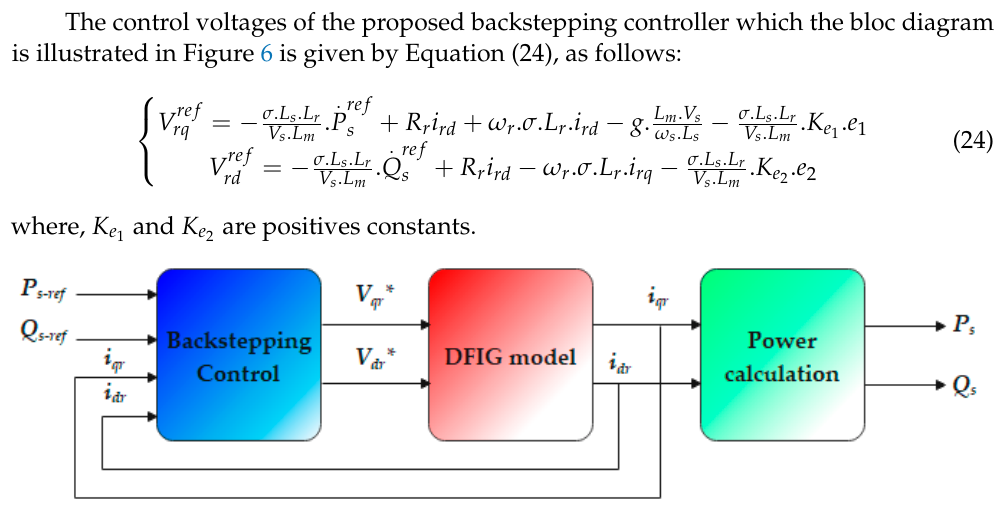
Figure 6. Backstepping control of the DFIG.